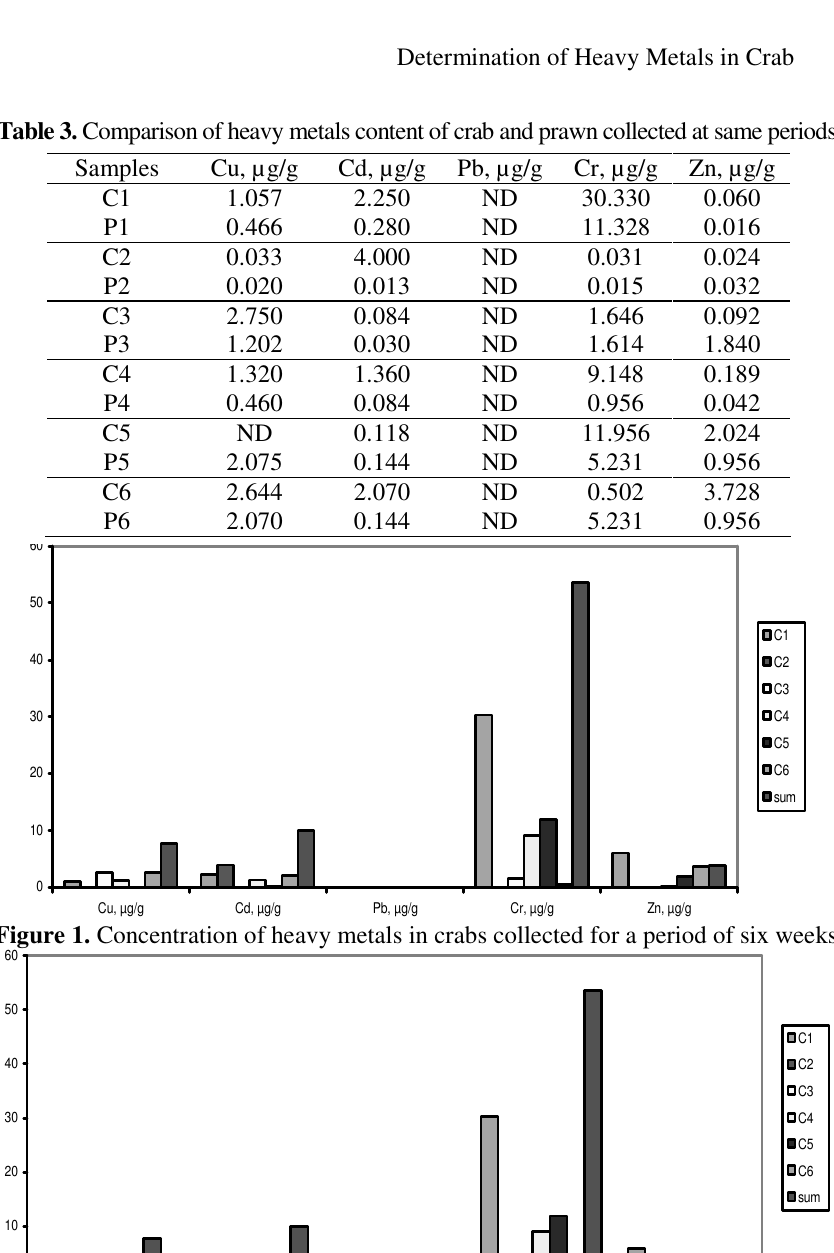
Figure 2. Concentration of heavy metals in prawns collected for a period of six